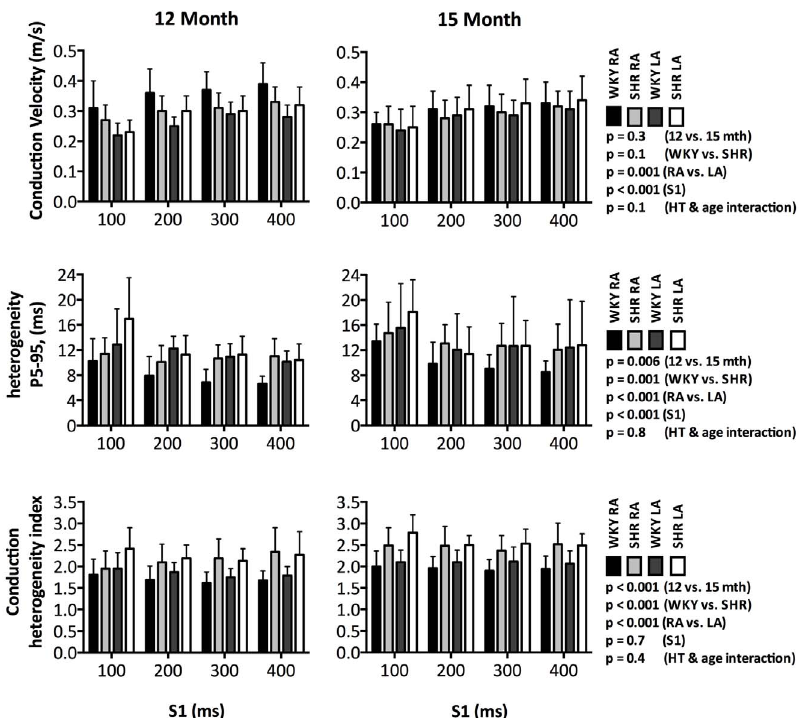
Figure 3. Atrial Conduction. Neither hypertension nor ageing had any significant effect on atrial conduction velocity (top row). In contrast, the SHR atria demonstrated higher absolute conduction heterogeneity (P5–95) and conduction heterogeneity index (P5–95/P50) than the WKY controls (middle & bottom rows). Both P5–95 and P5–95/P50 also increased significantly in tandem with ageing. In addition, increased pacing rate was associated with slower conduction velocity and higher P5–95 (top & middle rows). Significant differences were seen in all three conduction parameters between the left and right atrium.